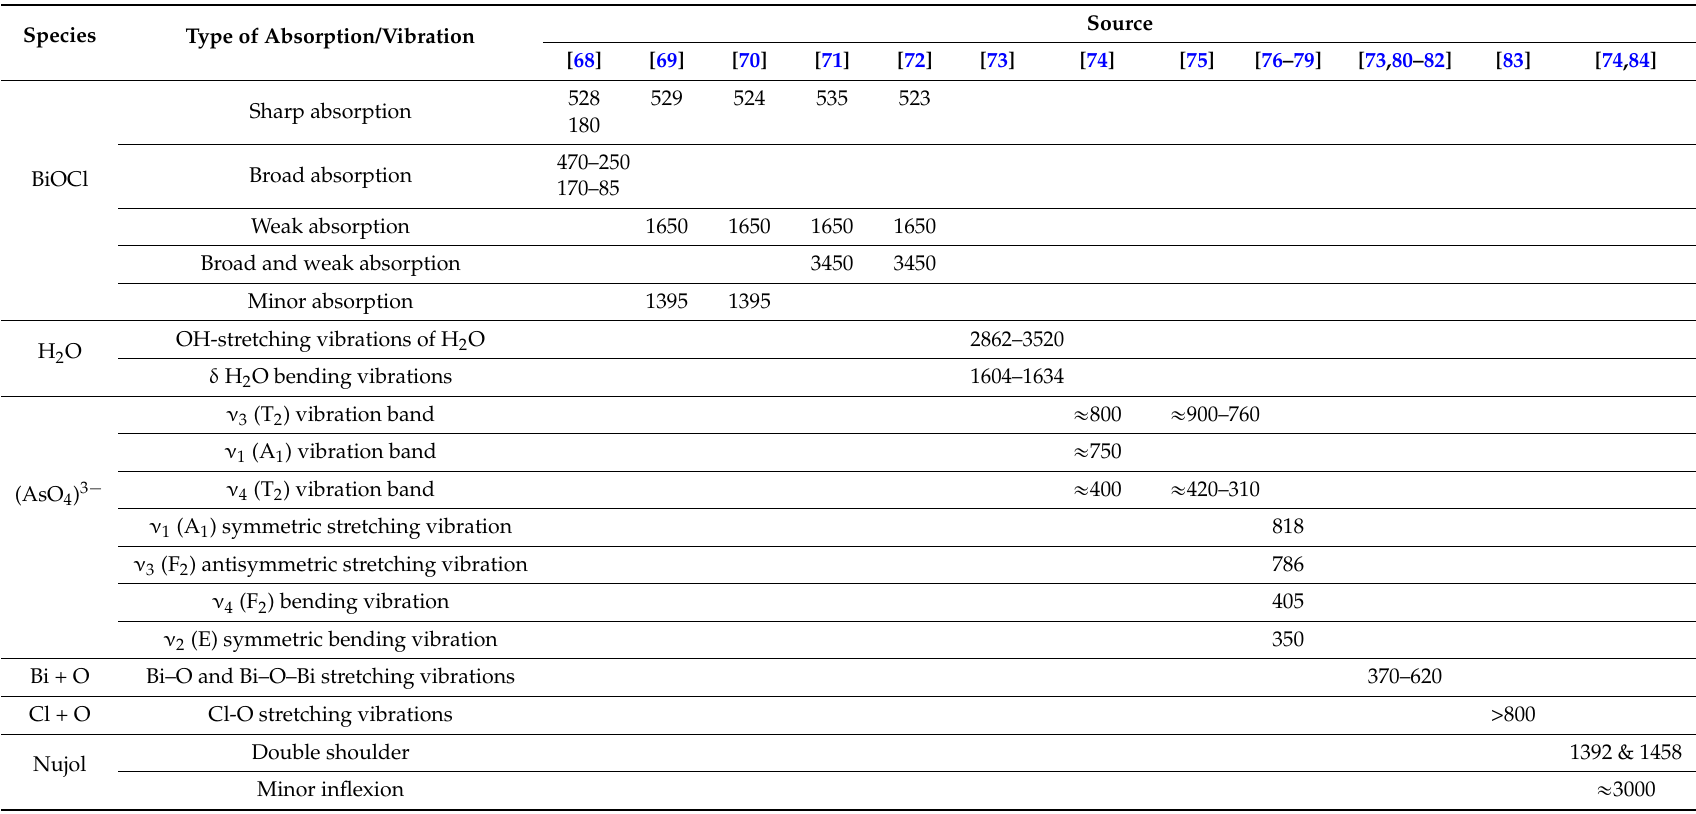
Table 8. Location of infrared absorption bands (cm ´ 1 ) of selected species based on published IR